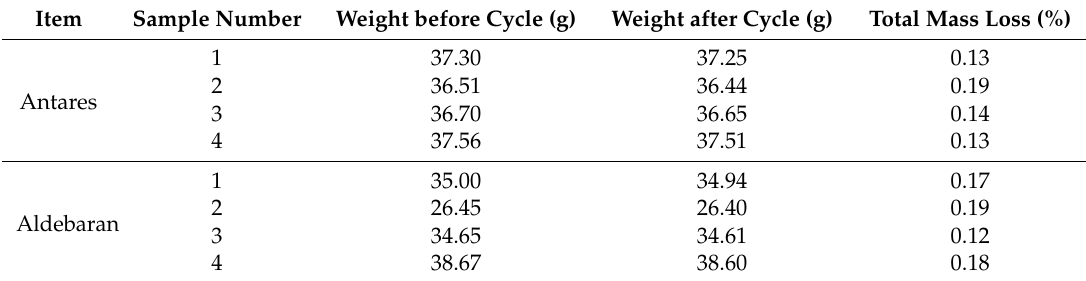
Table 3. Material samples weight and mass loss during the stabilization